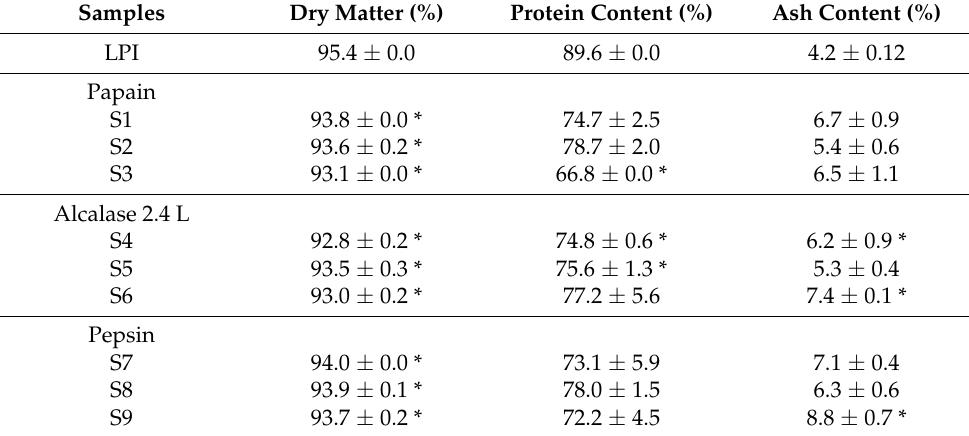
Table 3. Dry matter (%), protein content (%) and ash content (%) of lupin protein isolate (LPI) and fermented LPI hydrolysates.